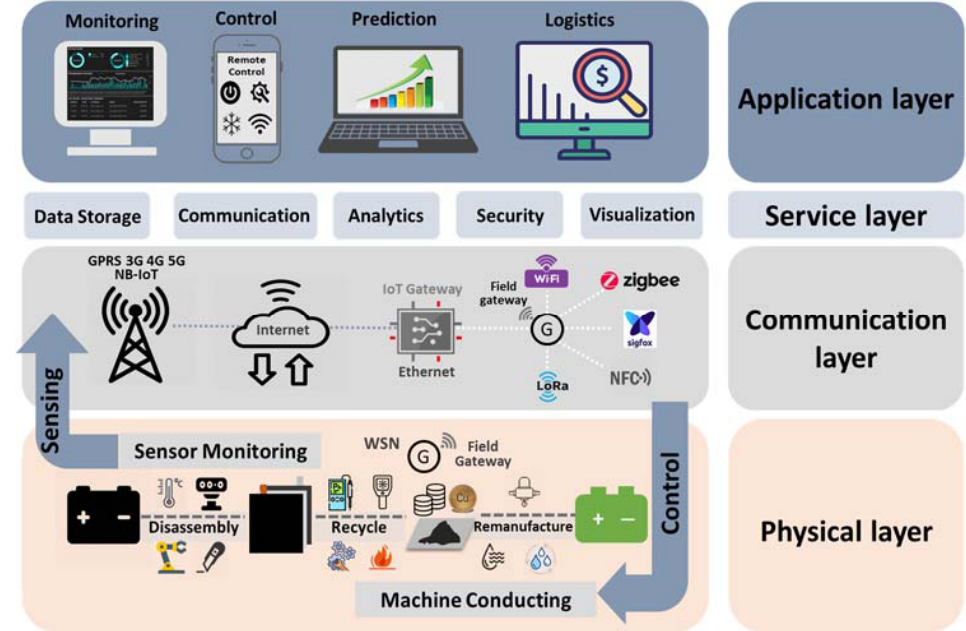
Figure 8. Proposed paradigm for IoT enhanced direct recycling of LIBs application [109].